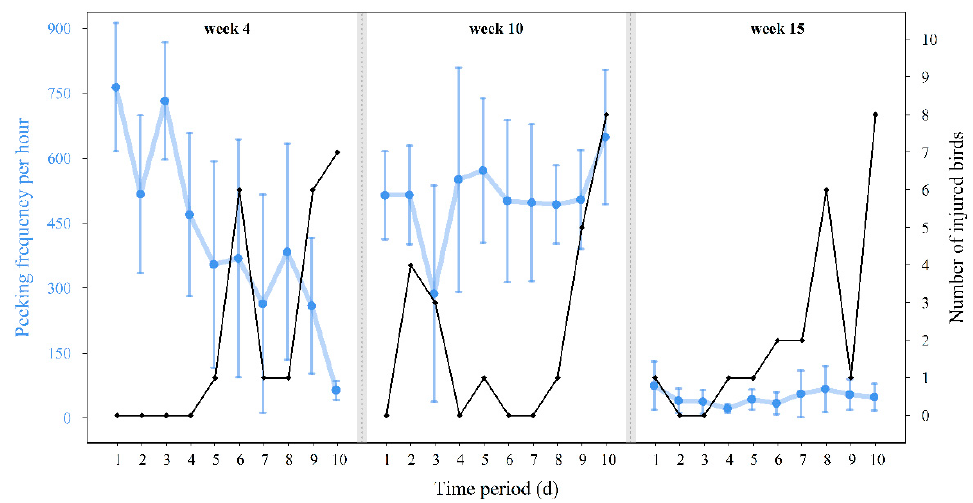
Figure 4. The development of mean values and standard deviations of pecking frequencies per hour (blue) from 9 days prior cannibalistic outbreaks and the outbreak day in weeks 4, 10, and 15 of life and numbers of injuries for each day (black, n = 12 h).